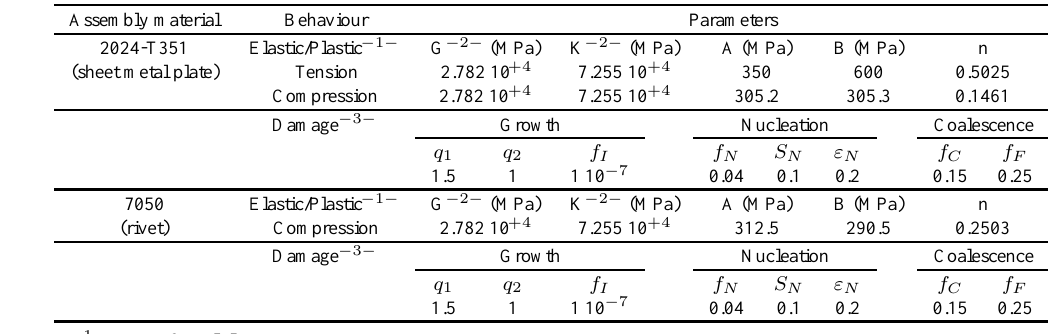
Fig. 1. Characterization specimens for Gurson damage model parameters identification. Table 1 Elastic, plastic and damage materials parameters of riveted joint FE